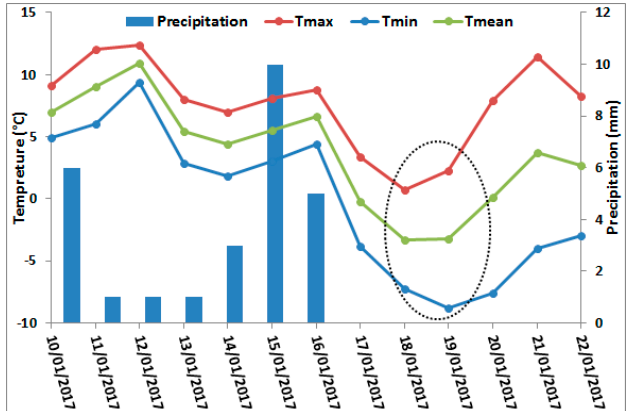
Figure 4. Temporal evolution of temperature and precipitation data recorded at a local meteorological station in Auch, Occitanie region.